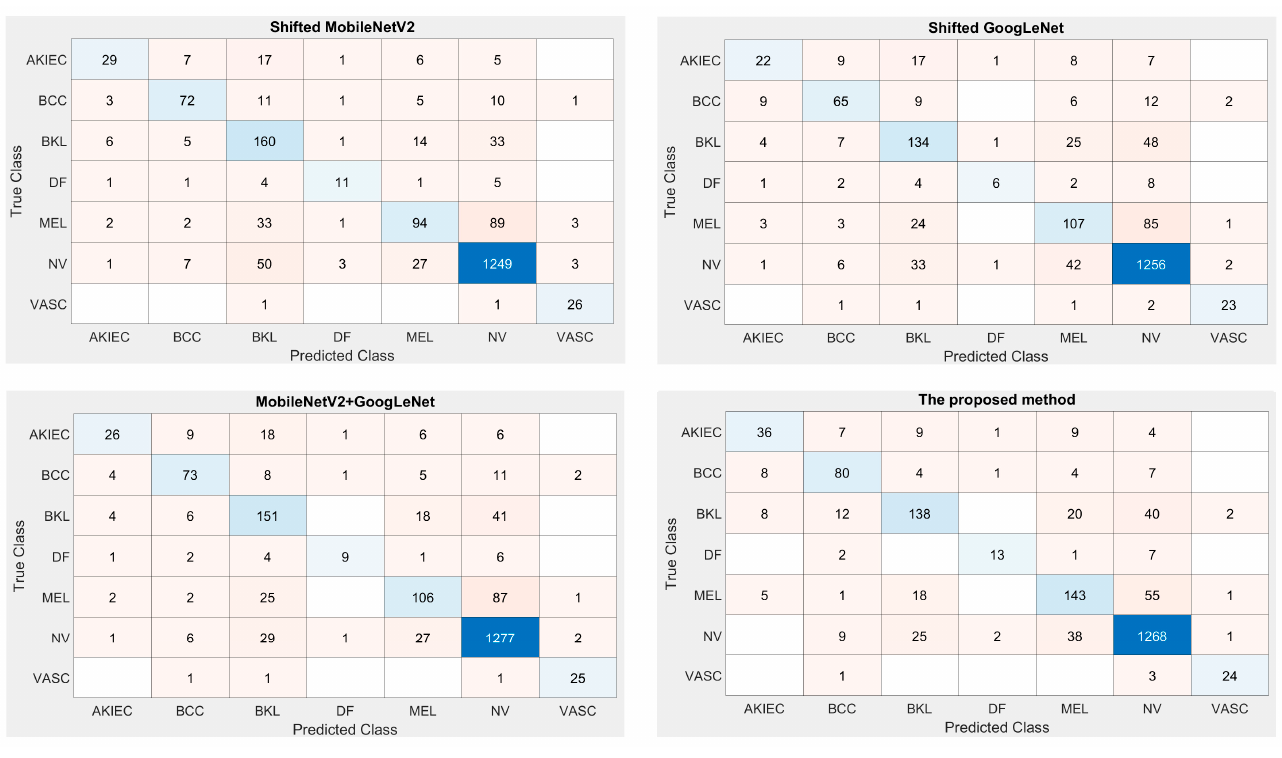
Figure 5. Confusion matrix of the four methods. Table 4. Comparison with different methods on the HAM10000 dataset in the first experiment Table 3. Comparison with different methods on the HAM10000 and ISIC2019 datasets.